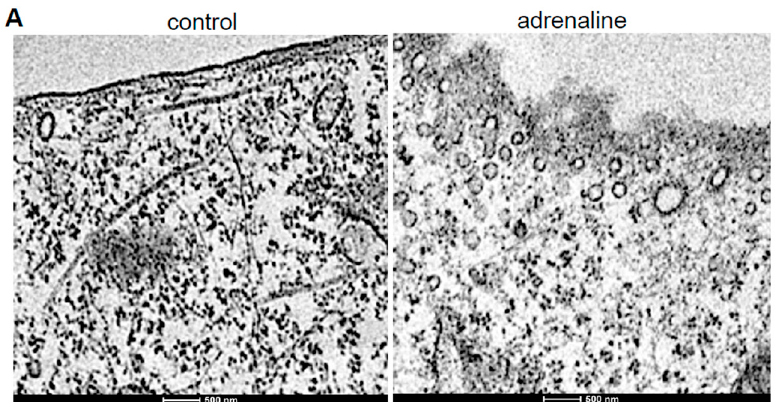
Figure 4. TEM images of the vasa vasorum of the hyalinosis lesions of the brain vessels of systemic hypertension patients. Brain tissues from systemic hypertension patients who underwent neurosurgery to remove the hematoma to treat hemorrhagic stroke were analyzed by TEM. ( A ) Arrows indicate the presence of the endothelial cell bulge. Magnification, × 5600. ( B ) Arrows indicate the presence of endocytic vesicles. Magnification, × 22,000. Representative images of n = 6 patients.